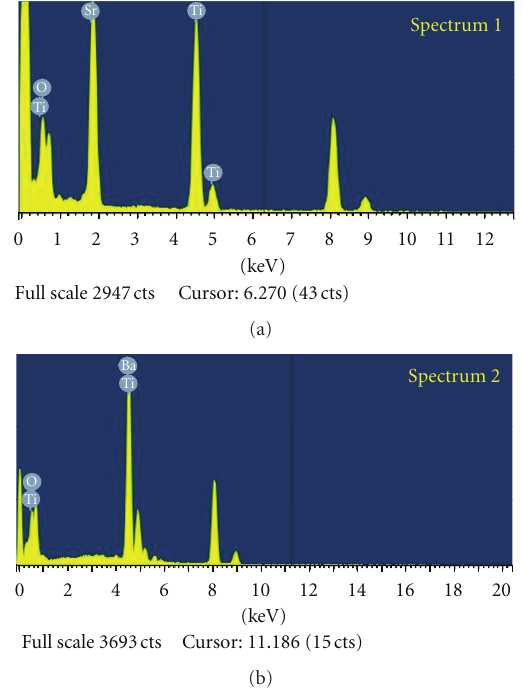
Figure 6: EDS of (a) strontium titanate and (b) barium